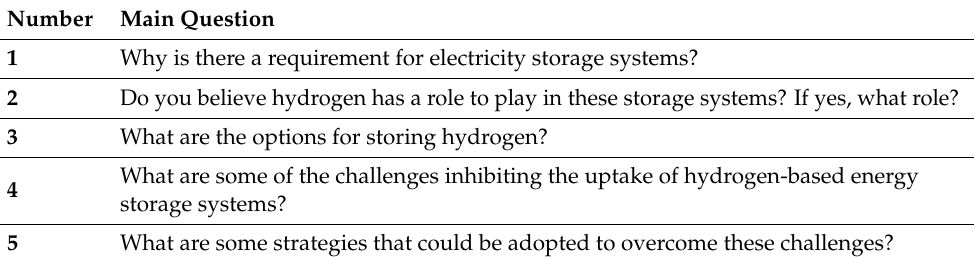
Table 1. Main questions.